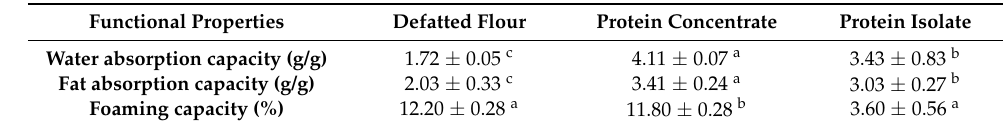
Table 9. Functional properties of defatted flour, protein concentrate, and protein isolate of Macrotermes subhyalinus